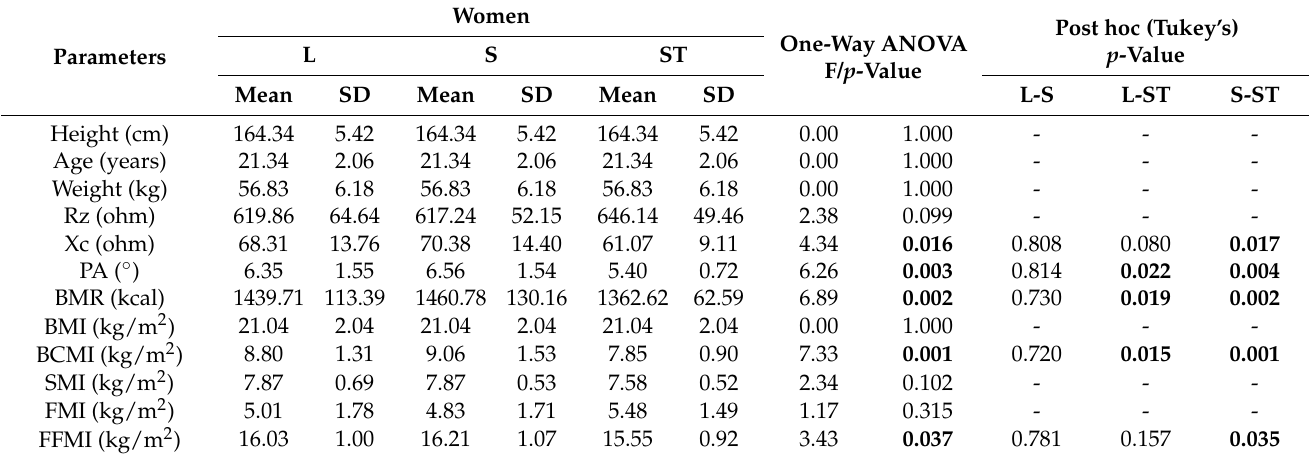
Table 2. Anthropometric and nutritional indicators among women.